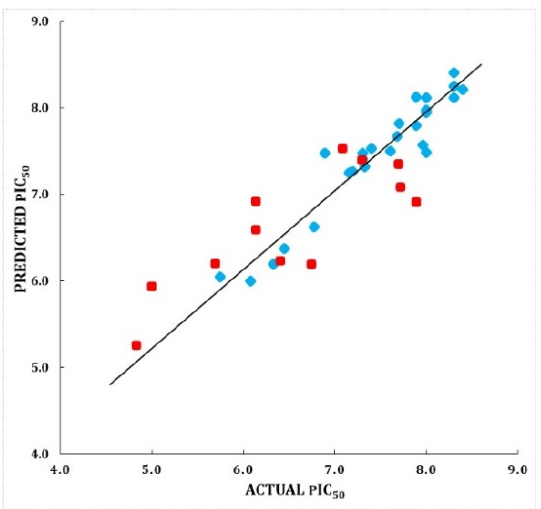
Figure 6. Scatter plot for the selected RF-CoMFA model; the plot shows the actual pIC 50 versus predicted pIC 50 activity of the training and test sets; the training set compounds are represented as blue diamonds; the test set compounds are represented as red